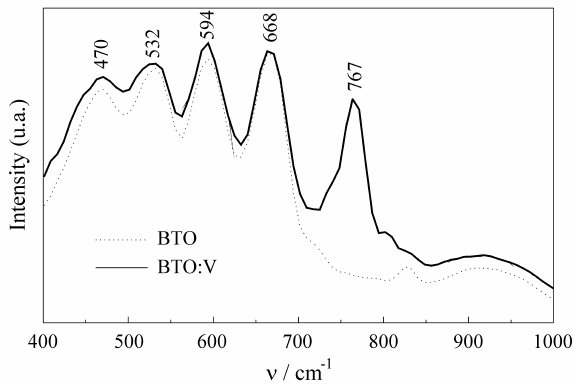
Figure 2. Photoacustic spectra between 400 to 1000 cm -1 of BTO and BTO:V samples. The absorption band centered at 767 cm -1 is charac- teristic of the (VO 4 ) -3 group in sillenite type crystals and the remainder are related to Bi-O